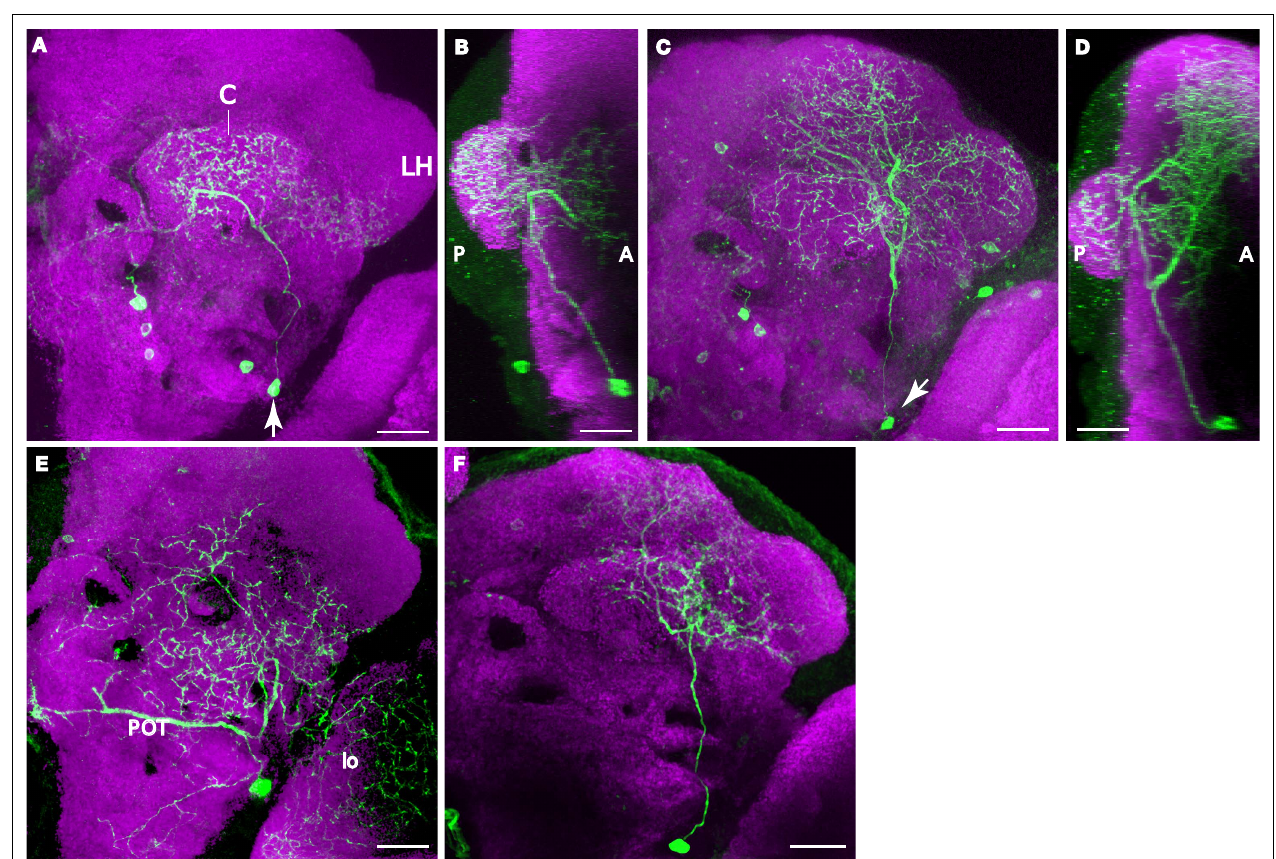
FIGURE 6 | Two types of PPL2ab neuron innervate the calyx of the mushroom body. In contrast to the PPL1 neurons that bilaterally innervate the mushroom body lobes, the innervation of each calyx is unilateral. Scale bar in all panels: 20 µm. (A) Posterior view of one type of PPL2ab neuron. The arrow points to the cell body. The primary neurite from this neuron extends dorsally. One branch innervates the calyx (C). A second branch innervates the adjacent posterior inferior lateral protocerebrum and the ventral portion of the lateral horn (LH). A third branch projects medially and innervates the middle inferior medial protocerebrum. Medial is to the left, lateral to the right. (B) Projection image of the neuron in panel (A) from a lateral point of view. Anterior is to the right, posterior to the left. (C) Posterior view of aother type of PPL2ab neuron (arrow points to the cell body). The primary neurite from this neuron extends dorsally